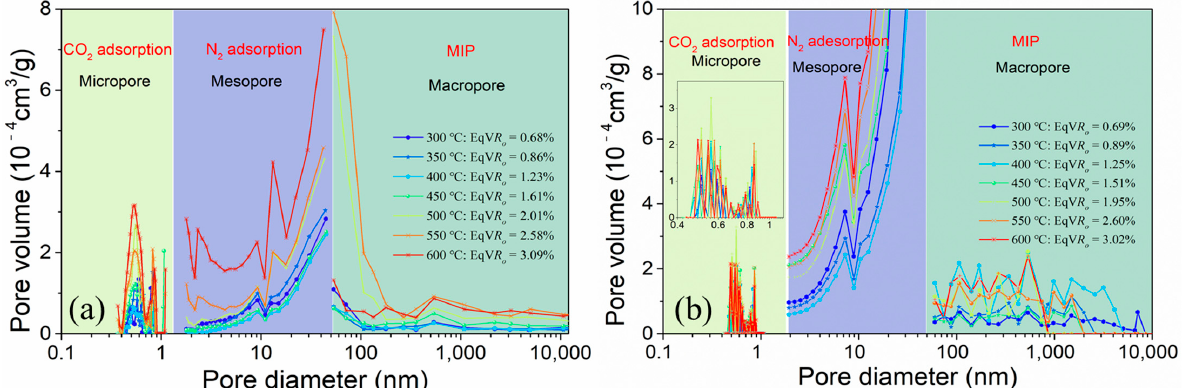
Figure 8. Full-scale pore size distribution of pyrolysis shales obtained by MIP, N 2 and CO 2 physisorption based on ( a ) open system and ( b ) semi-closed system pyrolysis experiments [21].